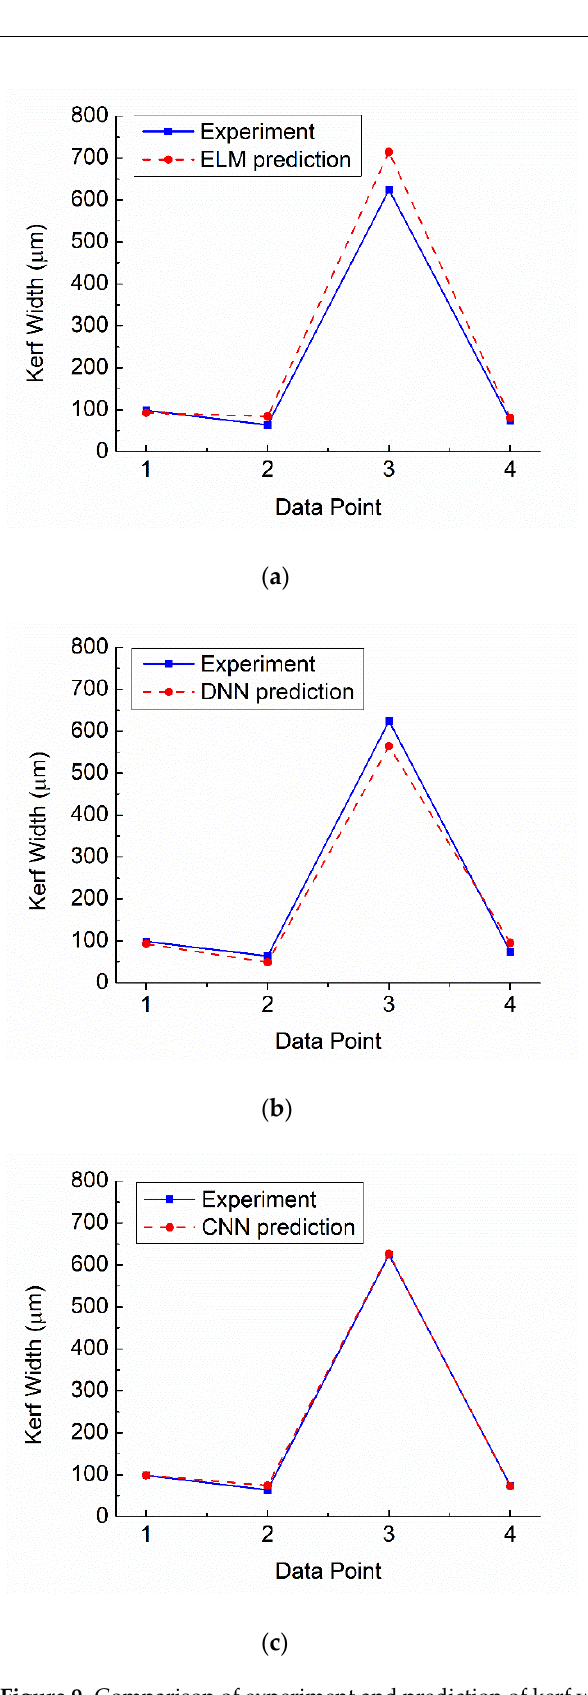
Figure 9. Comparison of experiment and prediction of kerf width for the same final test dataset using ( a ) ELM model, ( b ) DNN model, and ( c ) CNN model.